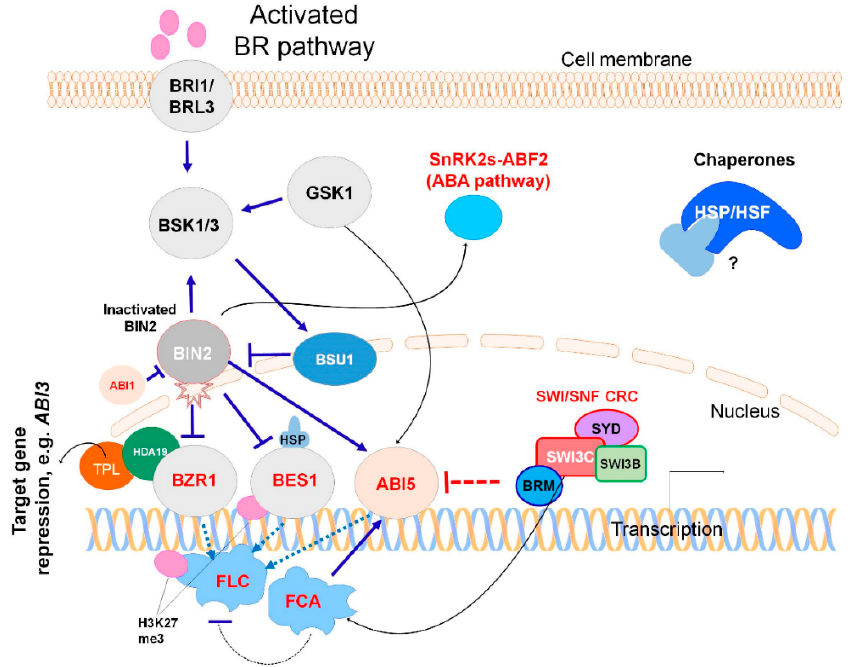
Figure 2. A model of stress memory generation by BR signaling. Solid lines represent protein–protein interactions and dotted lines represent transcriptional regulation. Proteins, involved in stress memory generation, are FLC and FCA (which substantially reduce plant water use and are important for heat and cold adaptation), TPL / HDA19 complex (ensures the epigenetic link between BR and ABA signaling through BZR1 / BES1-ABI3-ABI5 interactions), and key components of the ABA signaling system such as SnRK2.2 / 2.3 and OST1 / SnRK2.6, ABA-responsive element binding factors